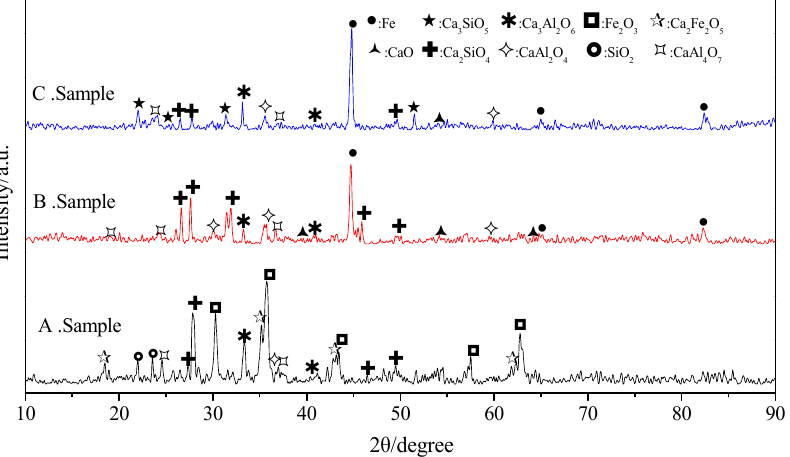
Figure 6. XRD patterns of hematite reduction roasting products.